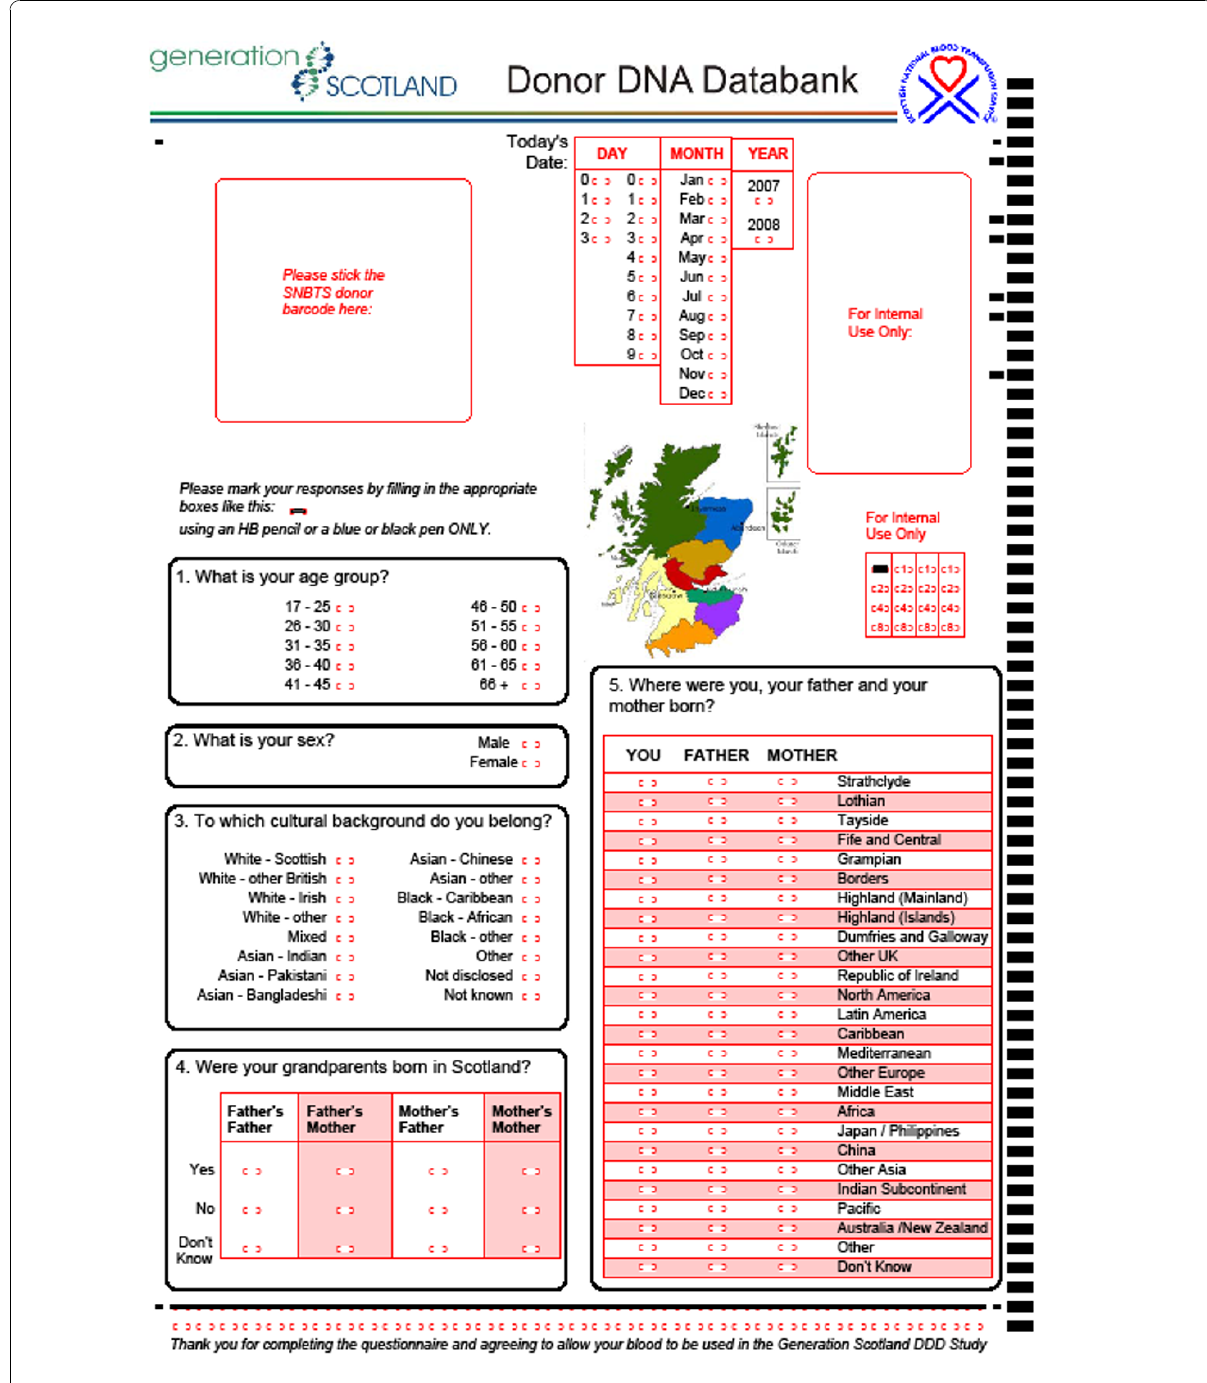
Figure 3 GS:3D Questionnaire . The Optical Mark Read